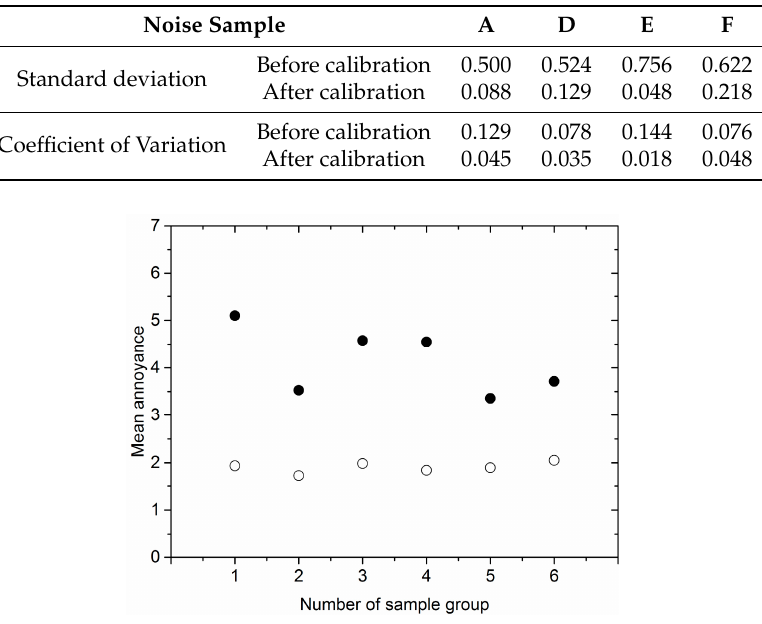
Figure 4. MA of sample A in sample sets 1–6 before and after calibration. ( ● : before calibration; ○ : after calibration).